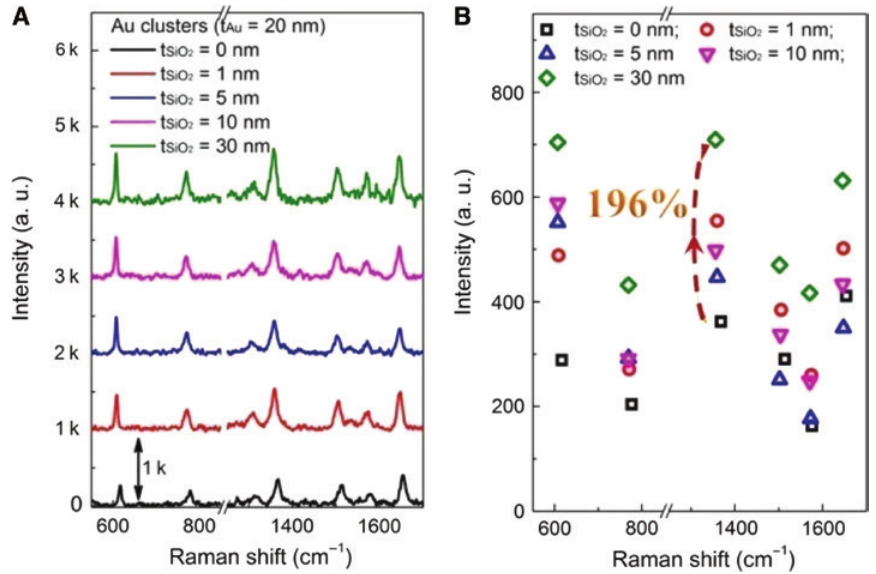
Figure 4: Surface-enhanced Raman scattering (SERS) performance for the Au clusters based substrate. (A) SERS spectral properties of the Au clusters under a tuning thickness of silica buffer layers. (B) The plotted intensity spectrum of the Raman modes as a function of the silica layer’s thickness. The dashed red arrow indicates a 196% enhancement factor for the 30-nm-thick SiO buffered Au clusters to that of the Au clusters structure without the silica film. 2